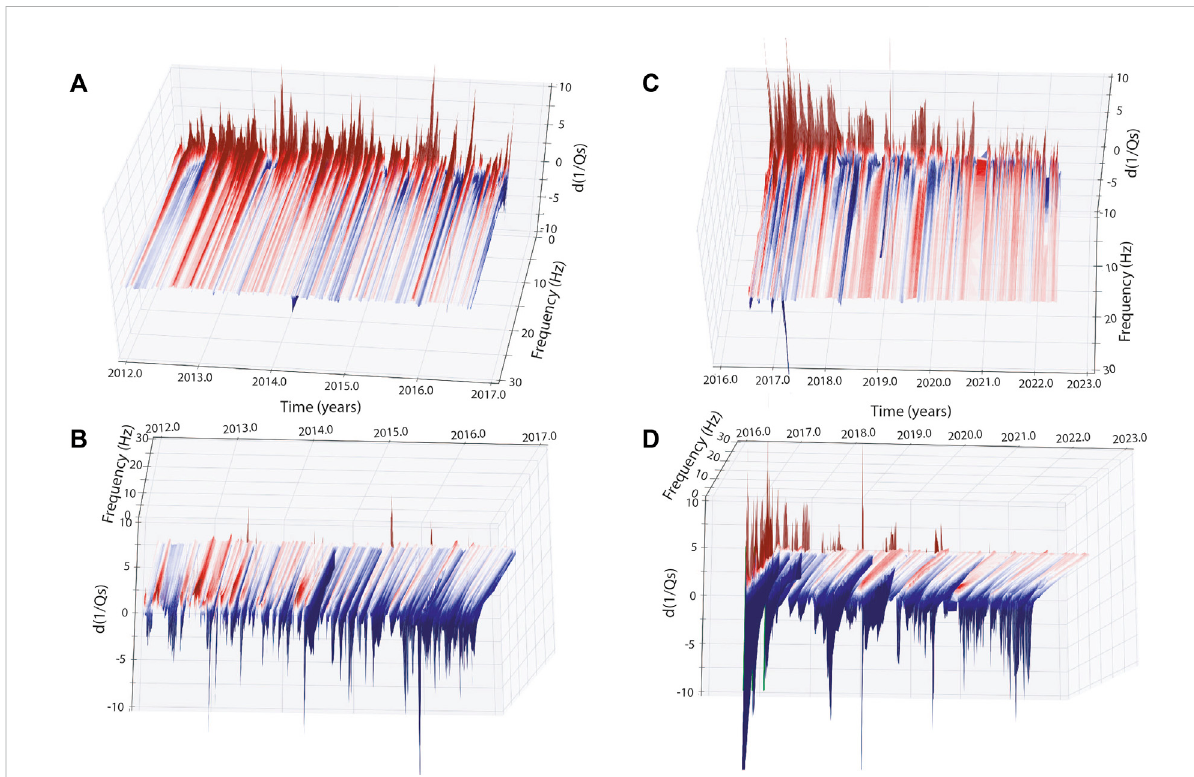
FIGURE 5 Seismic attenuation as a function of time and frequency, calculated at a hypocentral distance of 40 km. 3-D representations of the time- frequency variations of the parameter Q − 1 S ( f , t ) in the meizoseismal area of the 2016 – 2017 Amatrice-Visso-Norcia-Capitignano seismic sequence. The area (Figure 1) is limited by seismic stations ~30 km from either Amatrice, Visso, or Norcia. (A): time-frequency variations of Q − 1 S ( f , t ) , before the Amatrice main shock of 24 August 2016 (time window 2012/01/01 – 2016/08/23) (surface observed from above). (B) : same variability surface, observedfrombelow. (C) :Observedfromabove:afterthe fi rstmainshockoftheAmatricesequence(M6,24/08/2016),theseismicparameterinthe epicentral region undergoes an instantaneous drop due to the coseismic stress drop-induced negative dilatation. The latter produces a sudden reduction of the crustal bulk permeability via a reduction of crack density and interconnection. The strong ground shaking is responsible for a contrasting action that tends to increase crack density throughdamagein rocksthat are very close to thefreesurface(Rubinstein and Beroza, 2005; Kelly et al., 2013; Malagnini et al., 2019). Damage produces the positive peaks that affect the attenuation parameter at low-frequency (say, below 2.0 Hz) that occur immediately after the negative anomalies discussed earlier. Because low-frequency shaking is associated with surface waves, in such a portion of the spectrum, damage is the dominant effect over reduction of crack density and permeability produced by the coseismic stress drop. Labels on vertical axes refer to Q − 1 S ( f , t ) . (D) same as (C) , but the attenuation surface is observed from